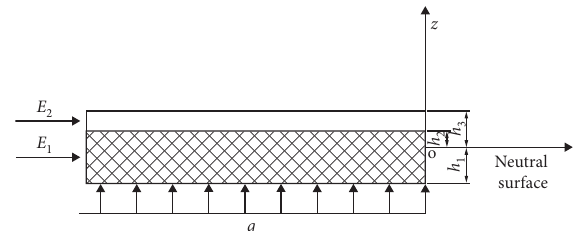
Figure 1: Mechanical model of the composite